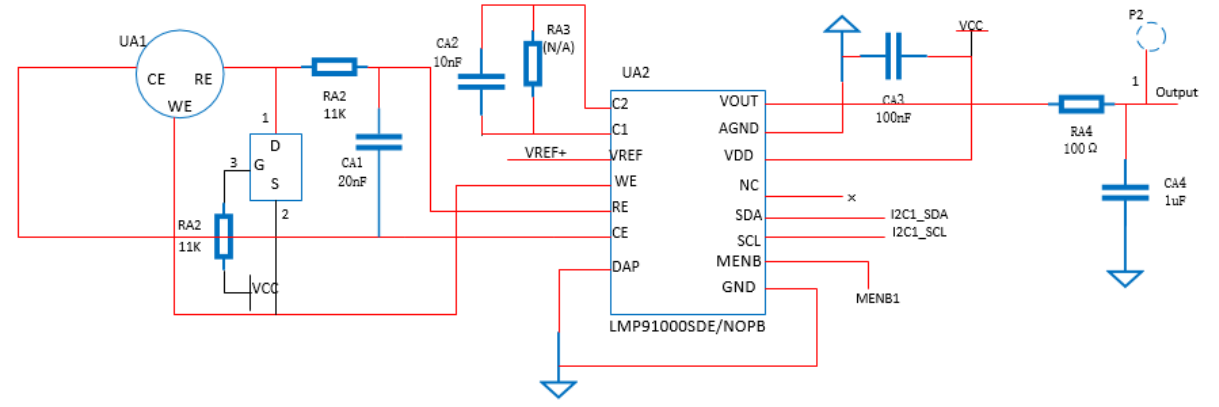
Figure 5. Electrochemical sensor circuit based on LM91000.